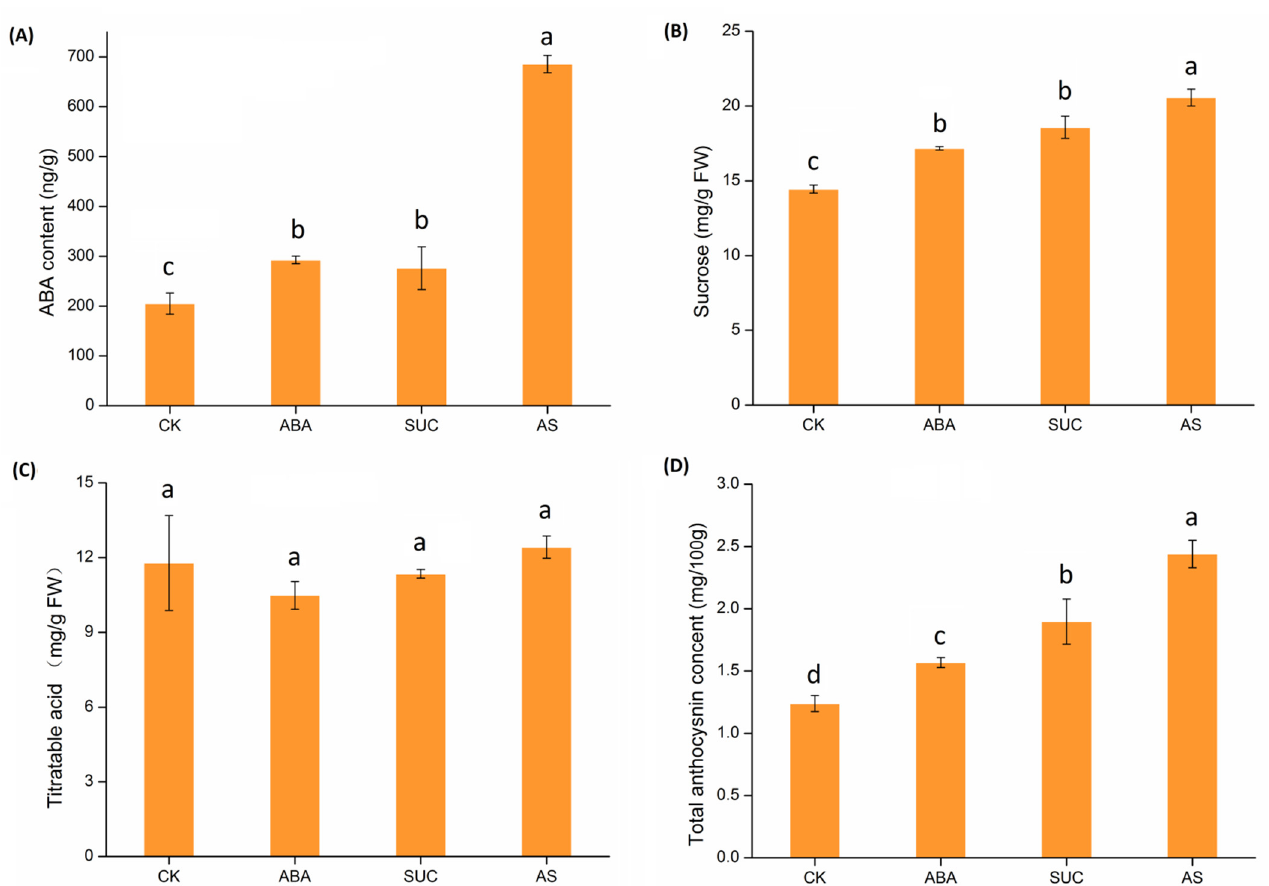
Figure 11. Effect of exogenous sucrose and ABA on the development of strawberry fruits. ( A ) ABA content; ( B ) Sucrose content; ( C ) Titratable acid content; ( D ) Total anthocyanin content. CK: control; ABA: abscisic acid; SUC: sucrose; AS: the mixture of abscisic acid and sucrose. Each bar represents the mean ± SD, T -test at the significance level of 0.05 ( p < 0.05), different letters (a–d) indicate significant difference, and the same letters indicate insignificant differences.